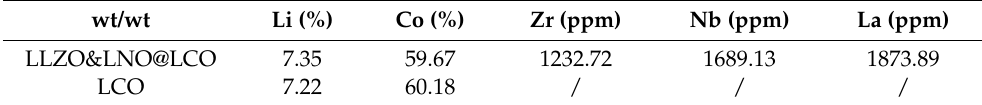
Table 1. Element composition and weight concentration of LLZO&LNO@LCO and